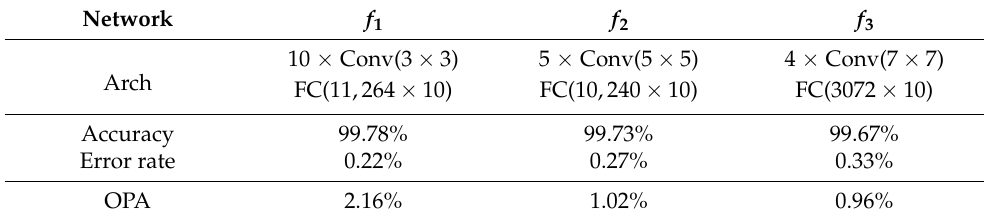
Table 1. Architectures and accuracies of